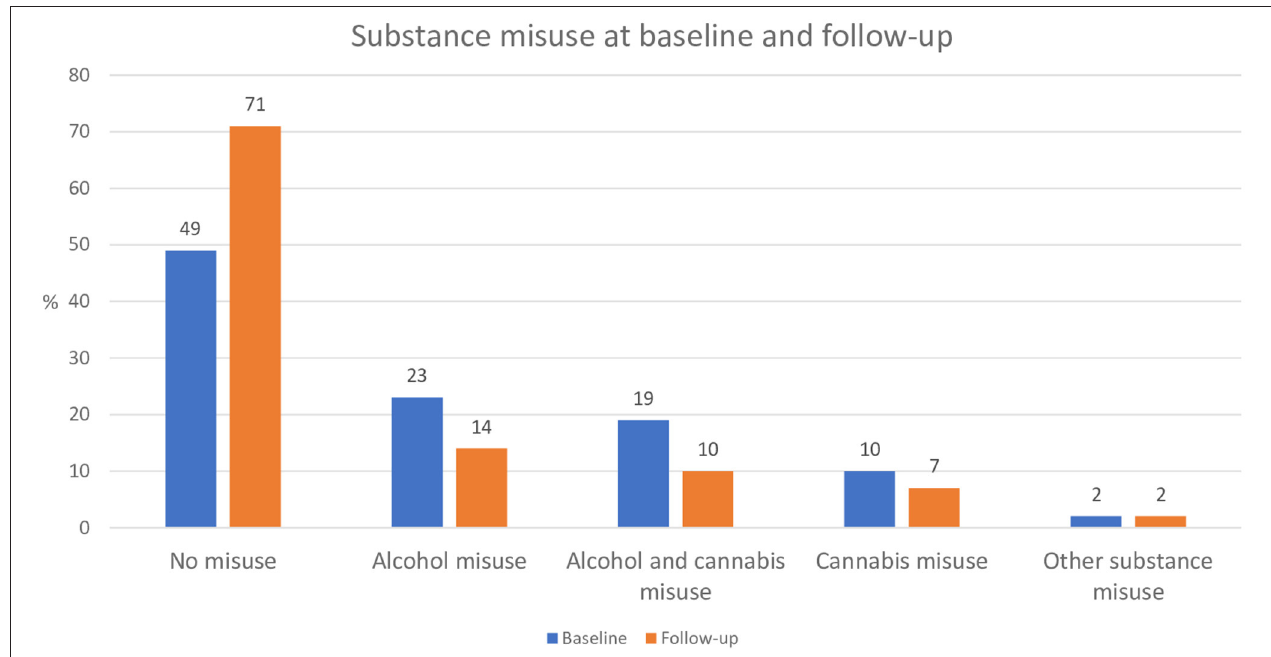
FIGURE 1 | Substance misuse at baseline and follow-up ( n = 112). Data is based on participants who completed follow-up only (i.e., baseline data on participants lost to follow-up is not